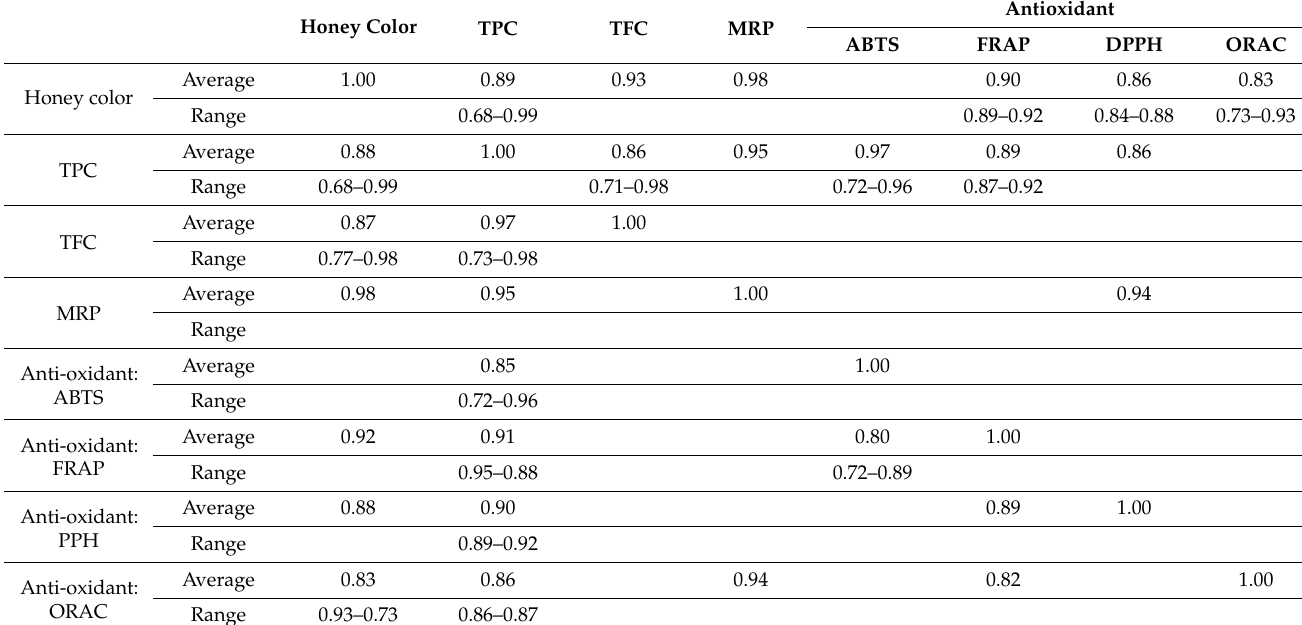
Table 2. Correlation matrix (all correlations are significant, p <